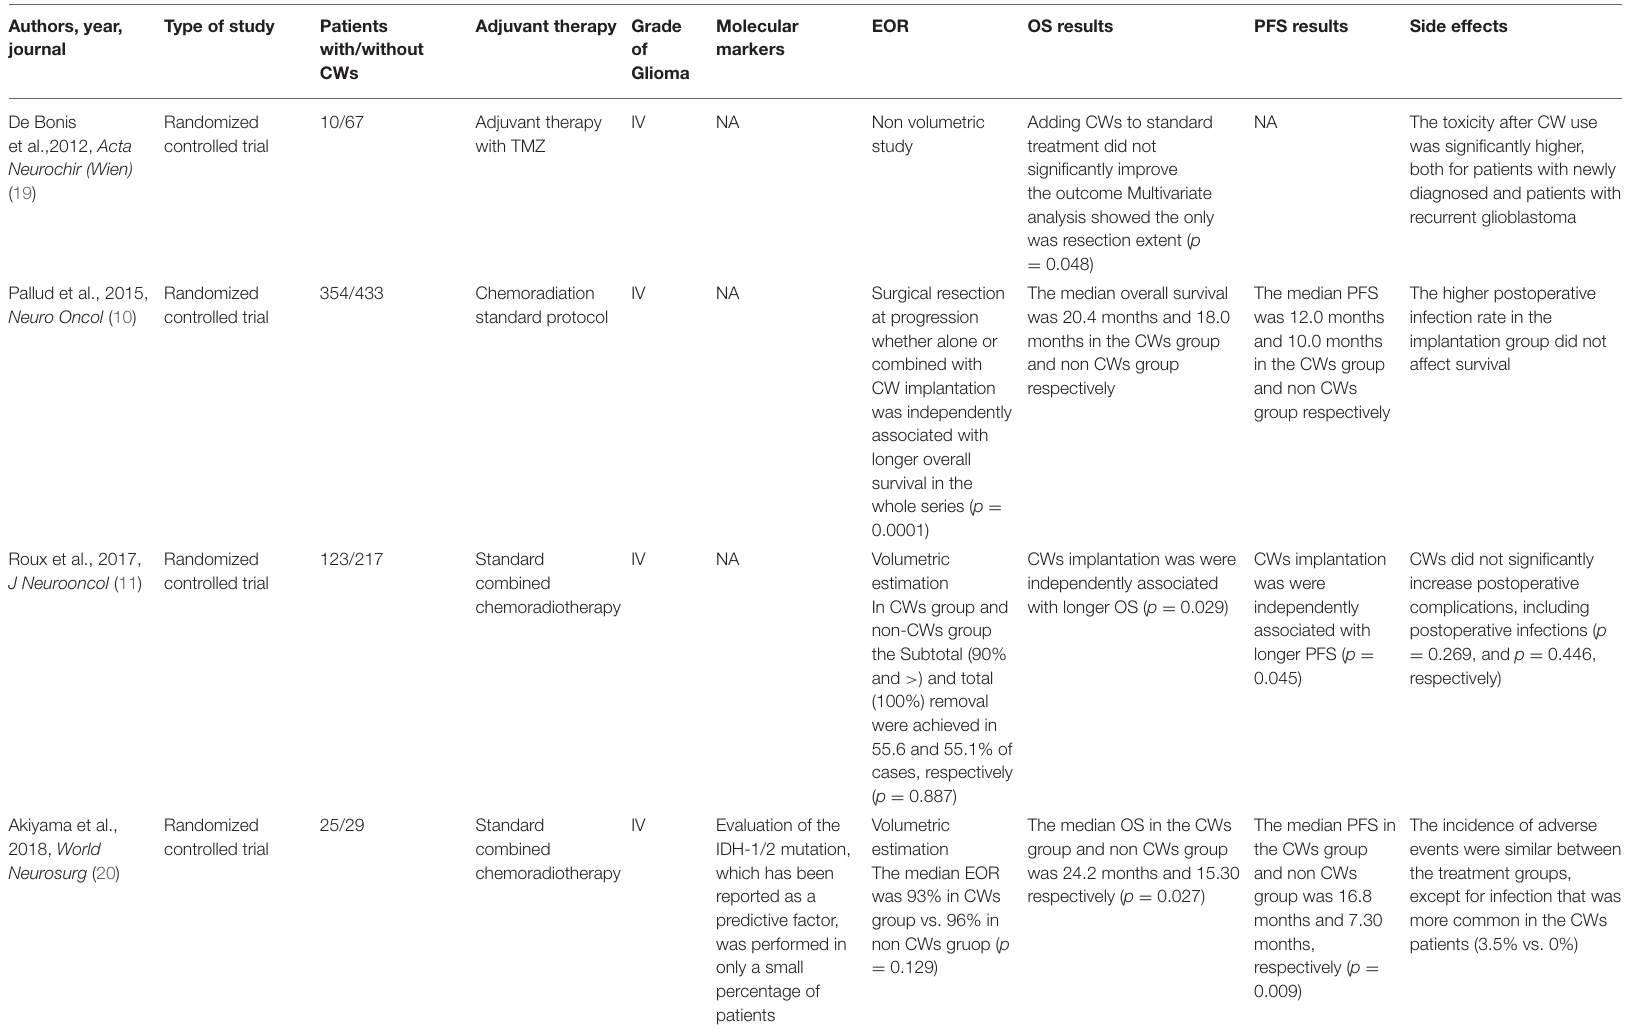
TABLE 2 | Characteristics of included